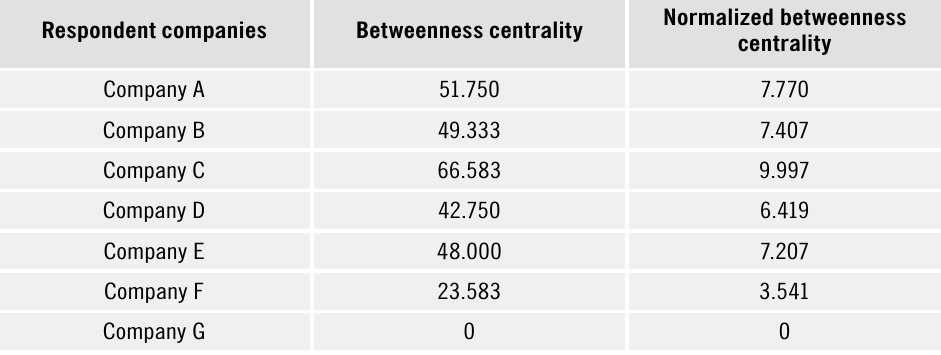
Table 7. Betweenness centrality parameters of the respondent companies with unweighted relations